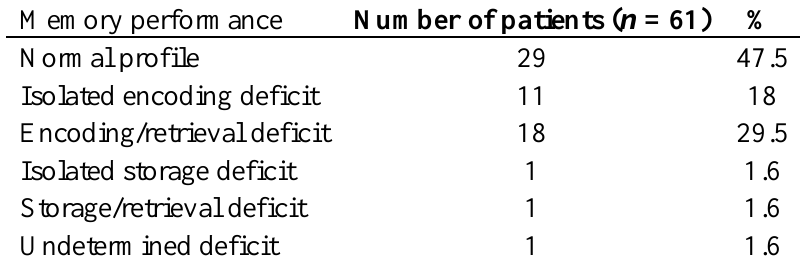
Table 2. Distribution of patients according to memory